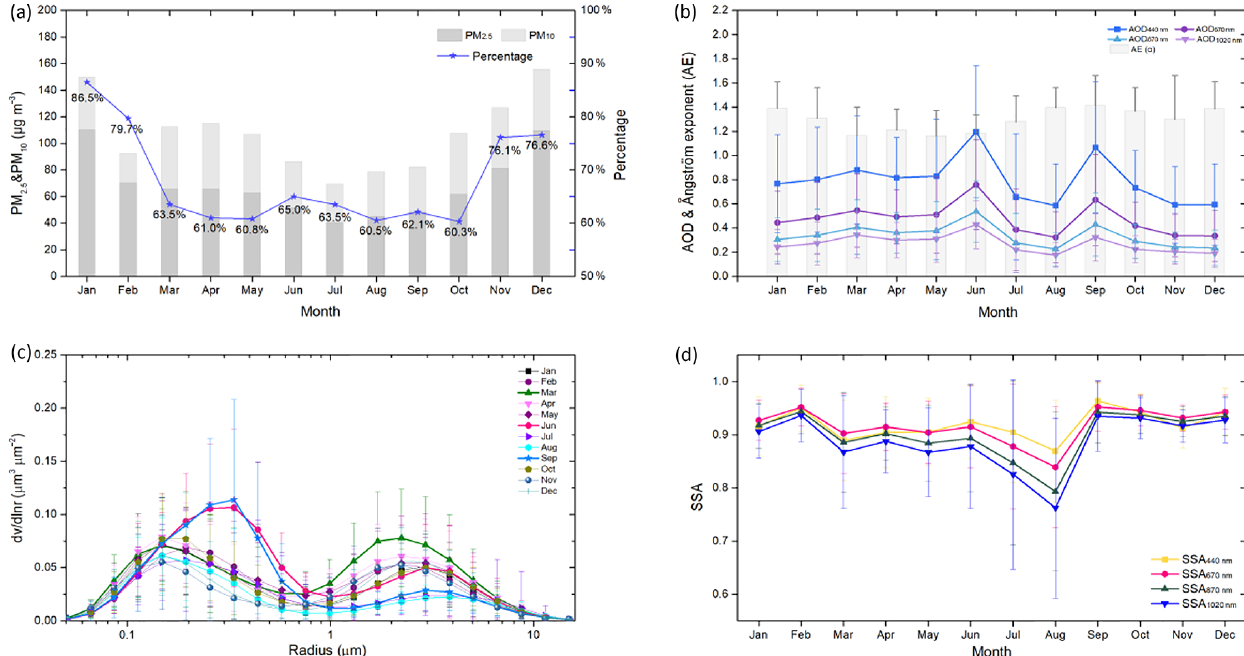
Figure 2. Monthly variation in averaged (a) mass concentration of PM 2 . 5 and PM 10 , (b) AOD (440, 670, 870, and 1020nm) and AE (between 440 and 870nm), (c) volume size distribution, and (d) SSA (440, 670, 870, and 1020nm), during 2013–2015 in